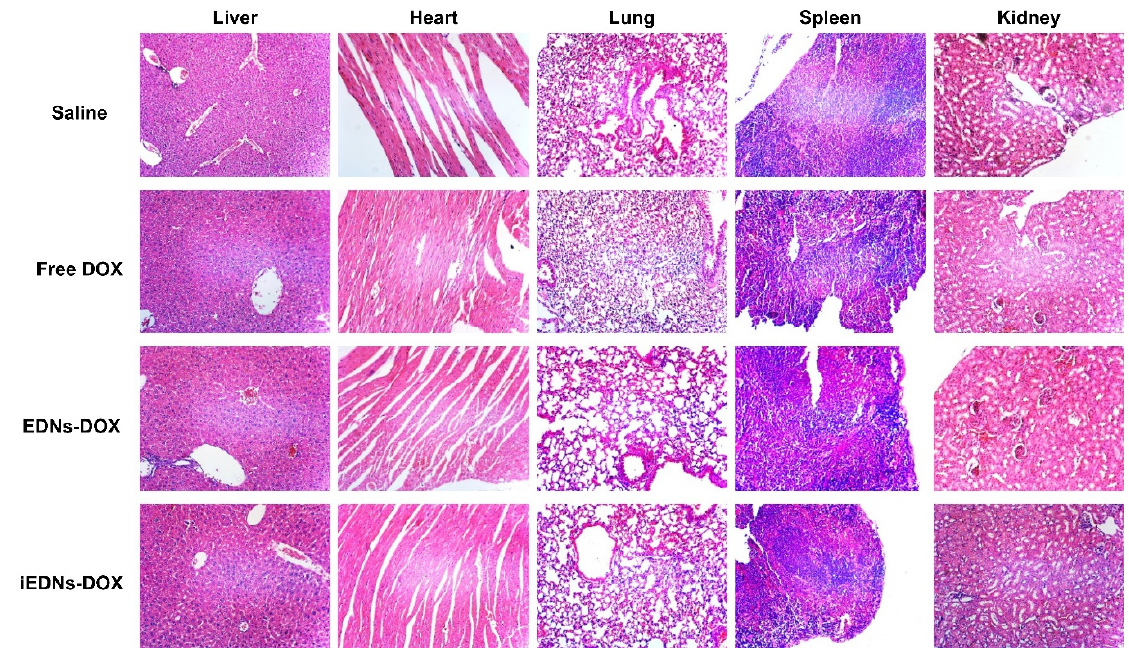
Figure 7. Histopathological examination of major internal organs of the mice injected with iEDNs- DOX. Major organs, including the liver, heart, lungs, spleen, and kidneys, were dissected from the treated mice on day 32 after the administration of various DOX formulations. The paraffin- embedded tissue sections of the organs were stained with H&E and observed under a light microscope. Magnification: ×